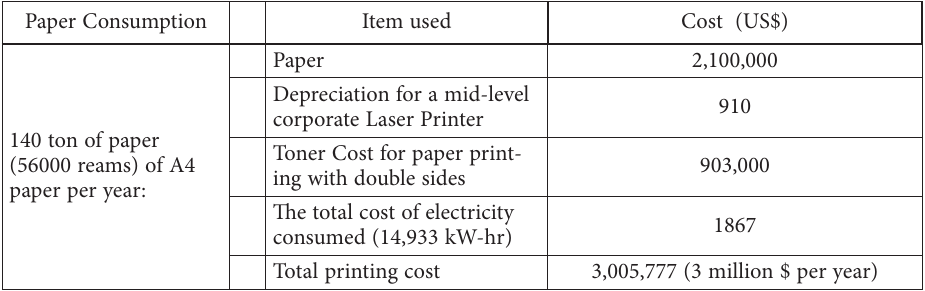
Table 1. Cost impact of paper consumption (source: Standard Chartered Bank, 2010) Paper Consumption